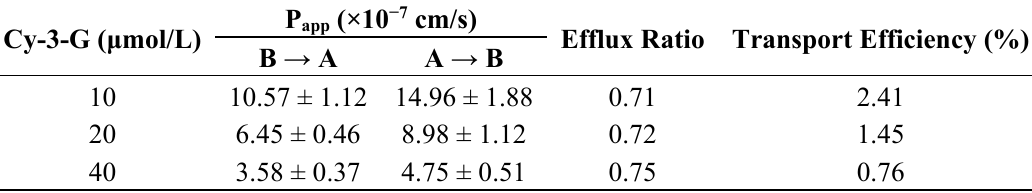
Table 1. Transport parameters of Cy-3-G across Caco-2 cell monolayer ( n =